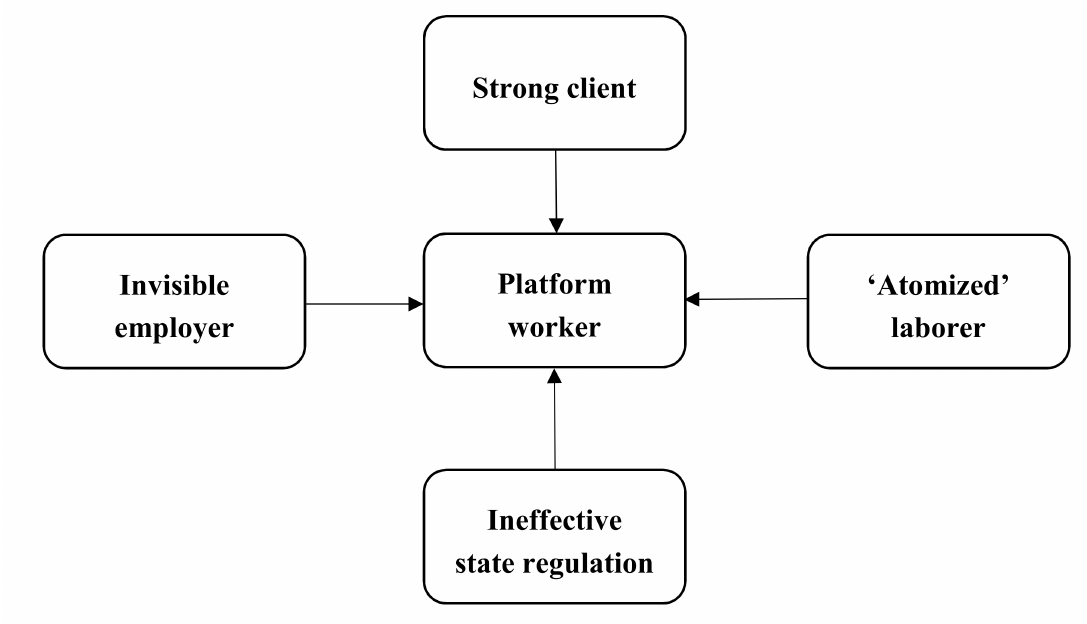
Figure 1. Workers embody an extremely weak position among stakeholders in the digital